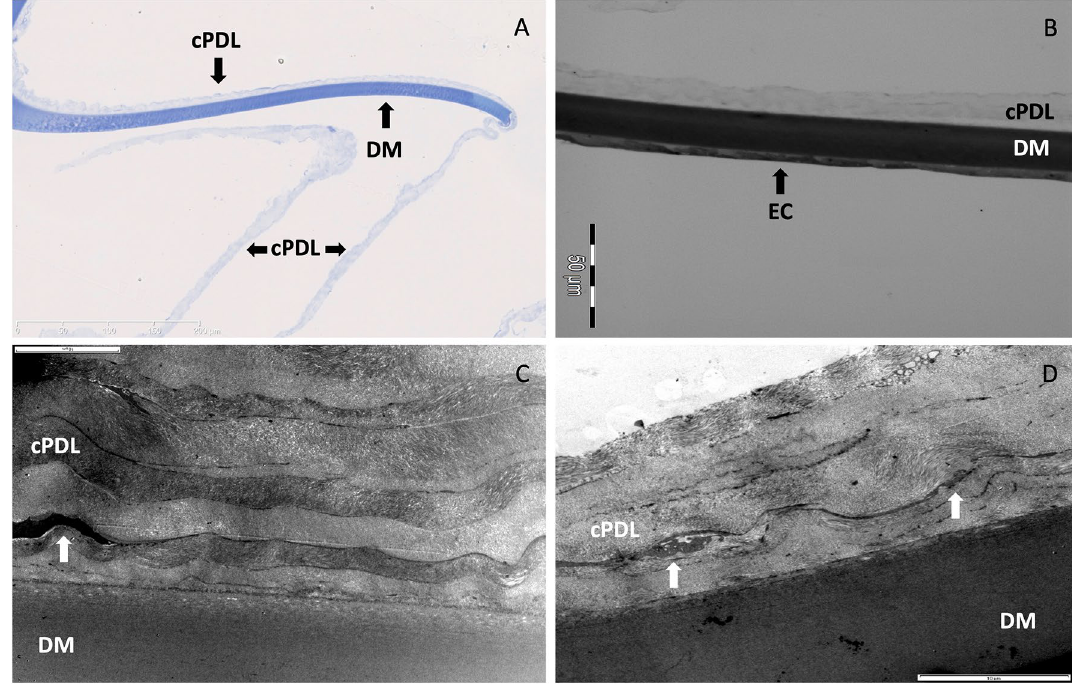
Figure 4. Histology of the canine pre-Descemet’s layer (cPDL). ( A ) Toluidine blue stained section of the cPDL and the Descemet’s membrane (DM). The DM is attached to part of the section of the cPDL. (Bar = 200 microns with 50-micron sections). ( B ) Transmission electron microscopy (TEM) of the wall of the type 1 big bubble (BB). The cPDL, DM and endothelial cells (EC) are illustrated. (Bar = 50 micros with 10-micron sections). ( C ) TEM of the cPDL anterior to the DM. A keratocyte is seen (white arrow). The compactly arranged horizontal and vertical lamellae are seen. Some oblique fibres are also visible (up and left) (Bar = 10 microns). ( D ) TEM of another section of cPDL, anterior to DM, showing keratocytes (white arrows) (Bar = 10